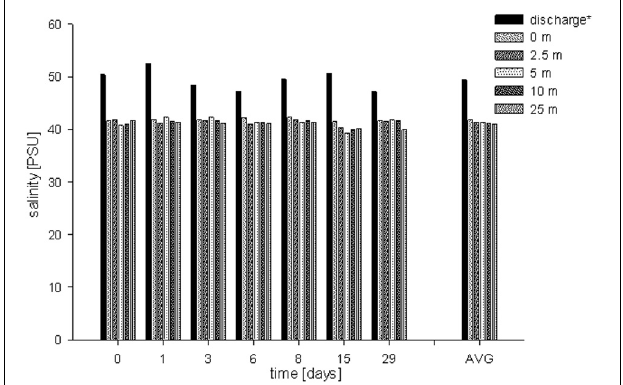
FIGURE 3 | Salinity concentrations measured for each sampling event at each station (6 time points, 6 stations). Average salinities: 49.4 ± 2.0 PSU (discharge screen), 41.8 ± 0.3 PSU (0m), 41.3 ± 0.6 PSU (2.5m), 41.3 ± 1.0 PSU (5m), 41.2 ± 0.6 PSU (15m) and 41.0 ± 0.7 PSU (25m), respectively. AVG shows the average salinity at each